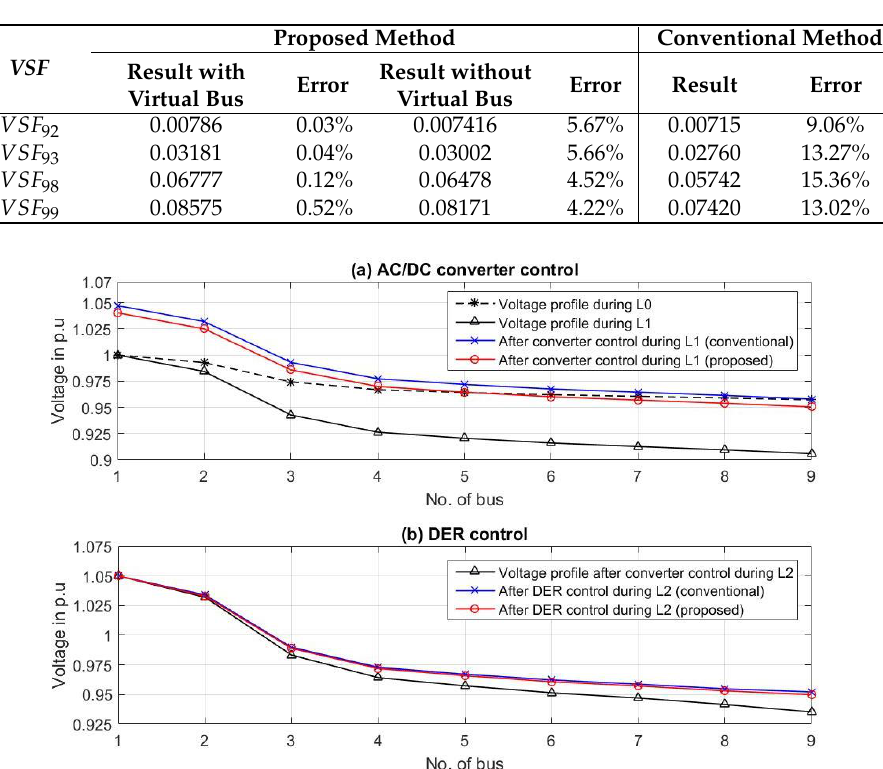
Figure 13. Power injection of the selected DER comparing the conventional and proposed methods. 5. Conclusions This paper presented a new voltage control scheme for LVDC distribution system using coordination control between the main AC/DC converter and multiple DERs based on MAS. The proposed method distributes power flow analysis and decision-making procedure to multiple local agents. Since local agents can detect voltage problems in real time and refine raw data to system information of the overall system, the computation burden in the master agent can be significantly relieved. For example, the roles of the local agents are to monitor the local bus voltage and currents, to detect the voltage problem and to request the voltage compensation. Local agents also compute the power system data such as corresponding rows of the system Jacobian matrix, power margin of DERs, line power flow and so on. All the functions of the local agents can be implemented in an affordable microcontroller.